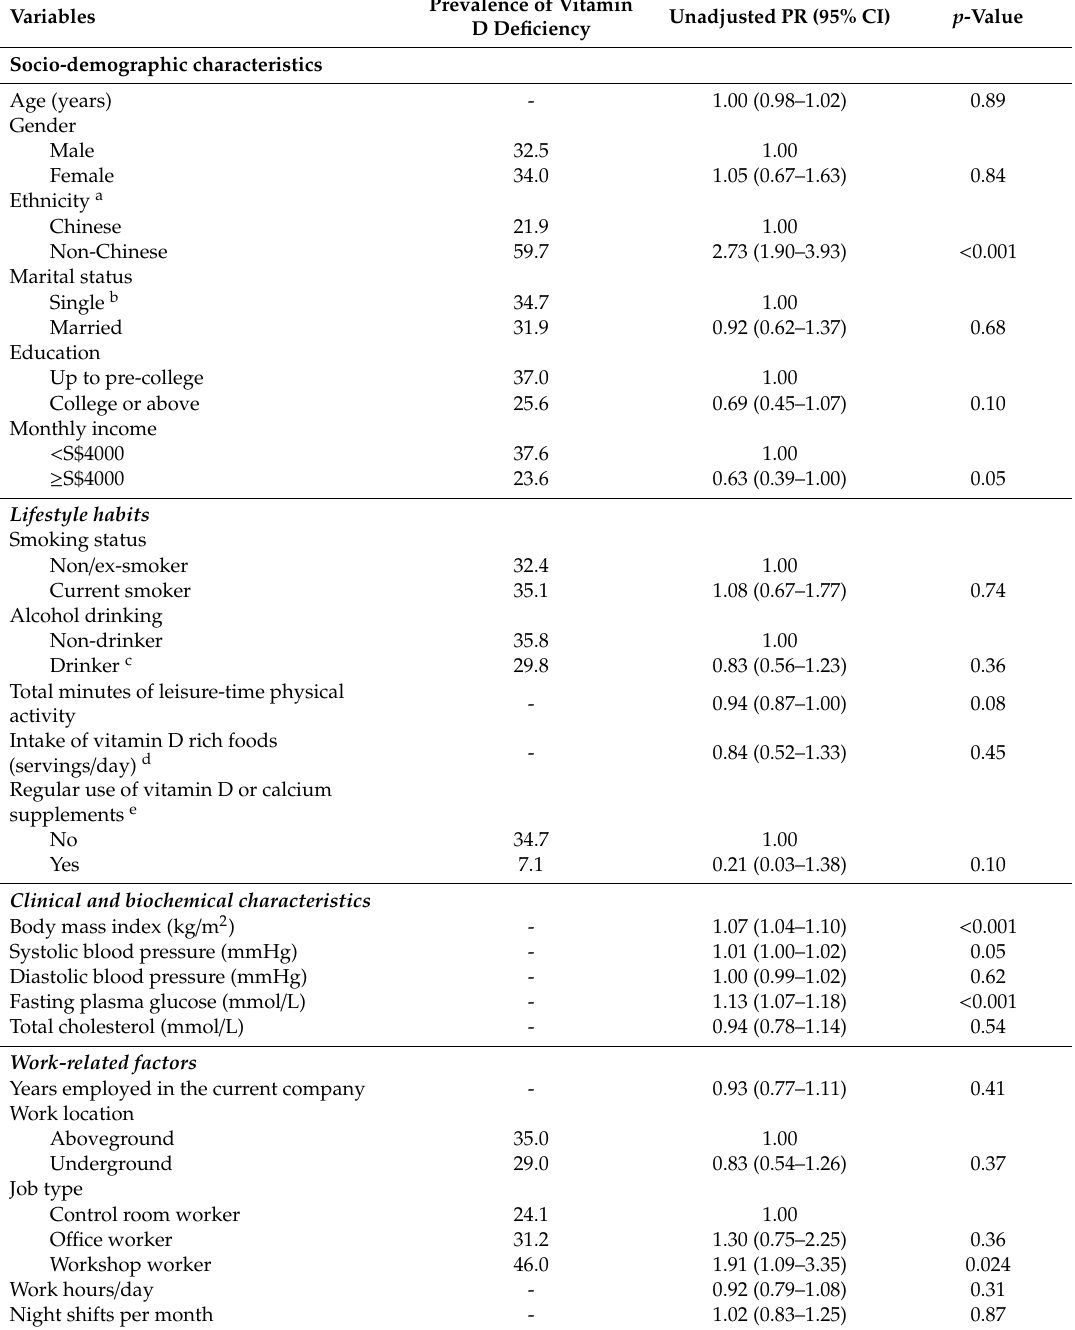
Table 2. Association of vitamin D deficiency with covariates; results of bivariate analysis. Variables